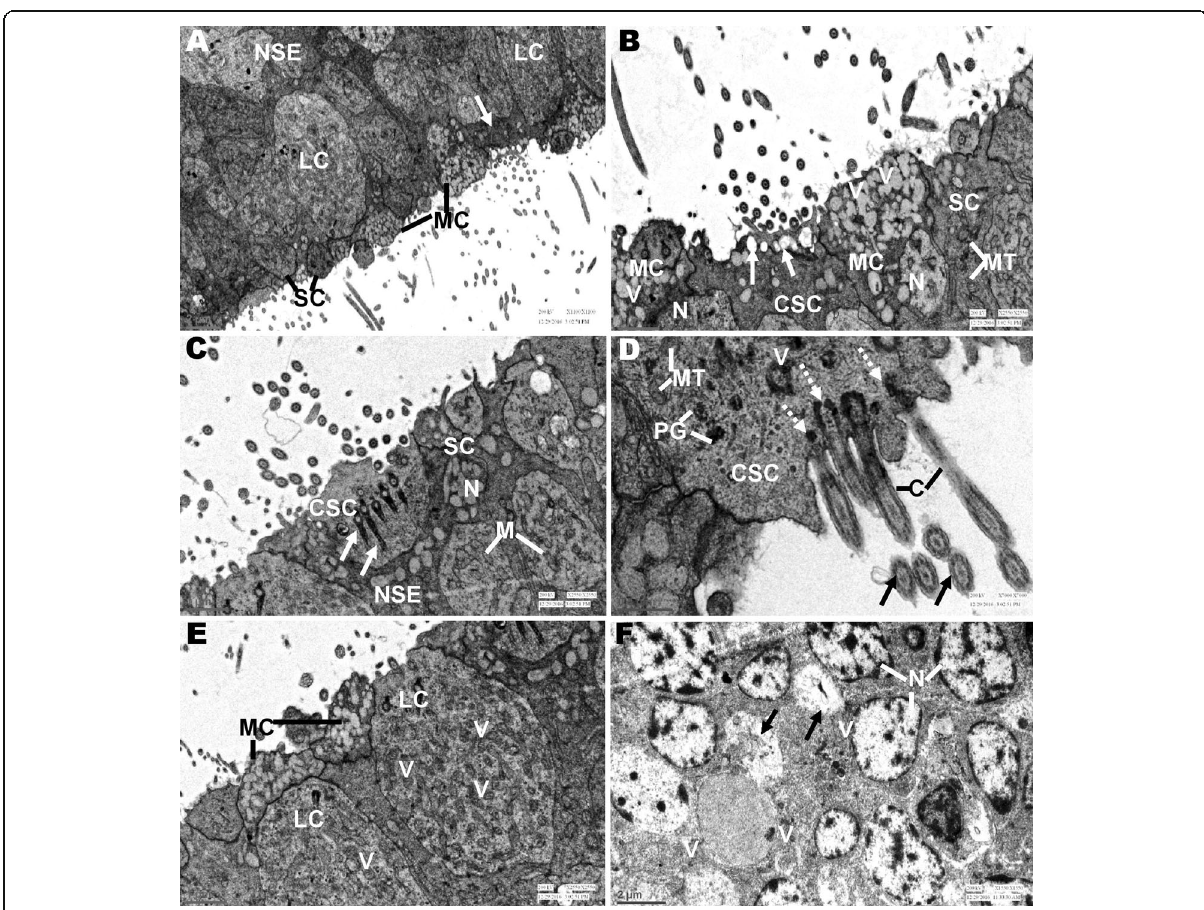
Fig. 6 Photomicrographs of the olfactory organ of E. vacha by transmission electron microscopy (TEM). A Nonsensory epithelium (NSE) lined with nonciliated supporting cells (SC), ciliated supporting cell (CSC) (solid arrow), labyrinth cells (LC), and mucous cell (MC). B Mucosa shows CSC with vacuoles (solid arrows), SC with mitochondria (MT), and MC containing basally placed nuclei (N) and secretory vesicles (arrow heads). C NSE typified with CSC having striated rootlets (solid arrows), mast cells (M), and SC containing nuclei (N). D Close up view of CSC shows plenty of kinocilia (C) with compact microtubules that arise from basal bodies (broken arrows), centriole (arrow head), mitochondria (MT), and pale granules (PG). Solid arrows mark classic arrangement of microtubules. E NSE shows labyrinth cells (LC) compacted with mitochondria (arrows) and vacuolated mucous cells (MC). F Raphe contains supporting cell nuclei (N) with dispersed heterochromatin. Note rough endoplasmic reticulum (arrow heads) and vesicles (solid arrows) adjacent to